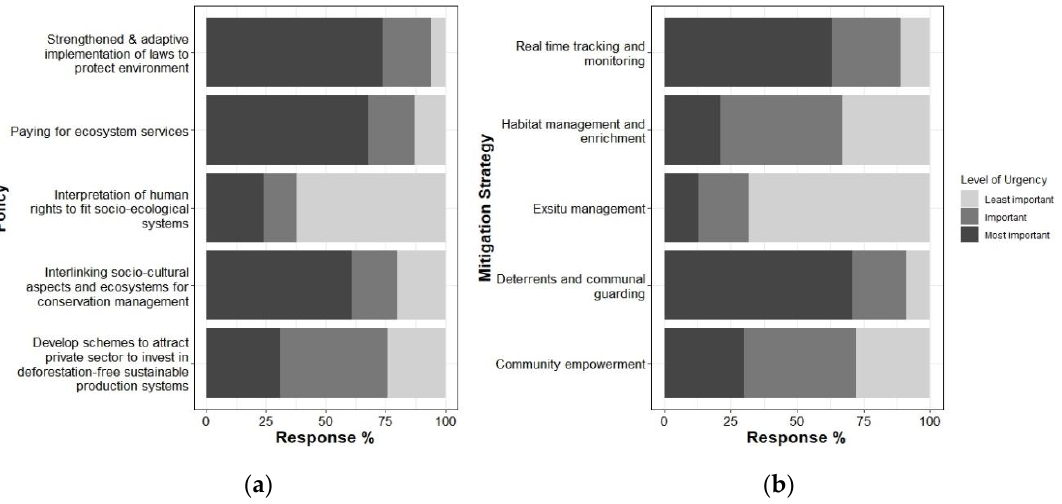
Figure 3. Experts’ opinions on ( a ) the most suitable policy instruments to manage human-elephant interaction by protecting the ecosystems and preserving the elephant range and ( b ) high priority human-elephant conflict mitigation strategies for the conflict-prone regions.